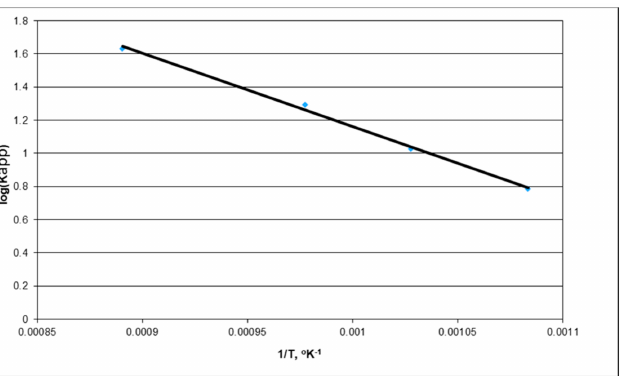
Figure 11. Estimation of apparent activation energy using an Arrhenius plot (S/C—5.0, GHSV— 12,800 h − 1 , catalyst—7.5% Ni-montmorillonite, naphthalene loading—58 g/Nm 3